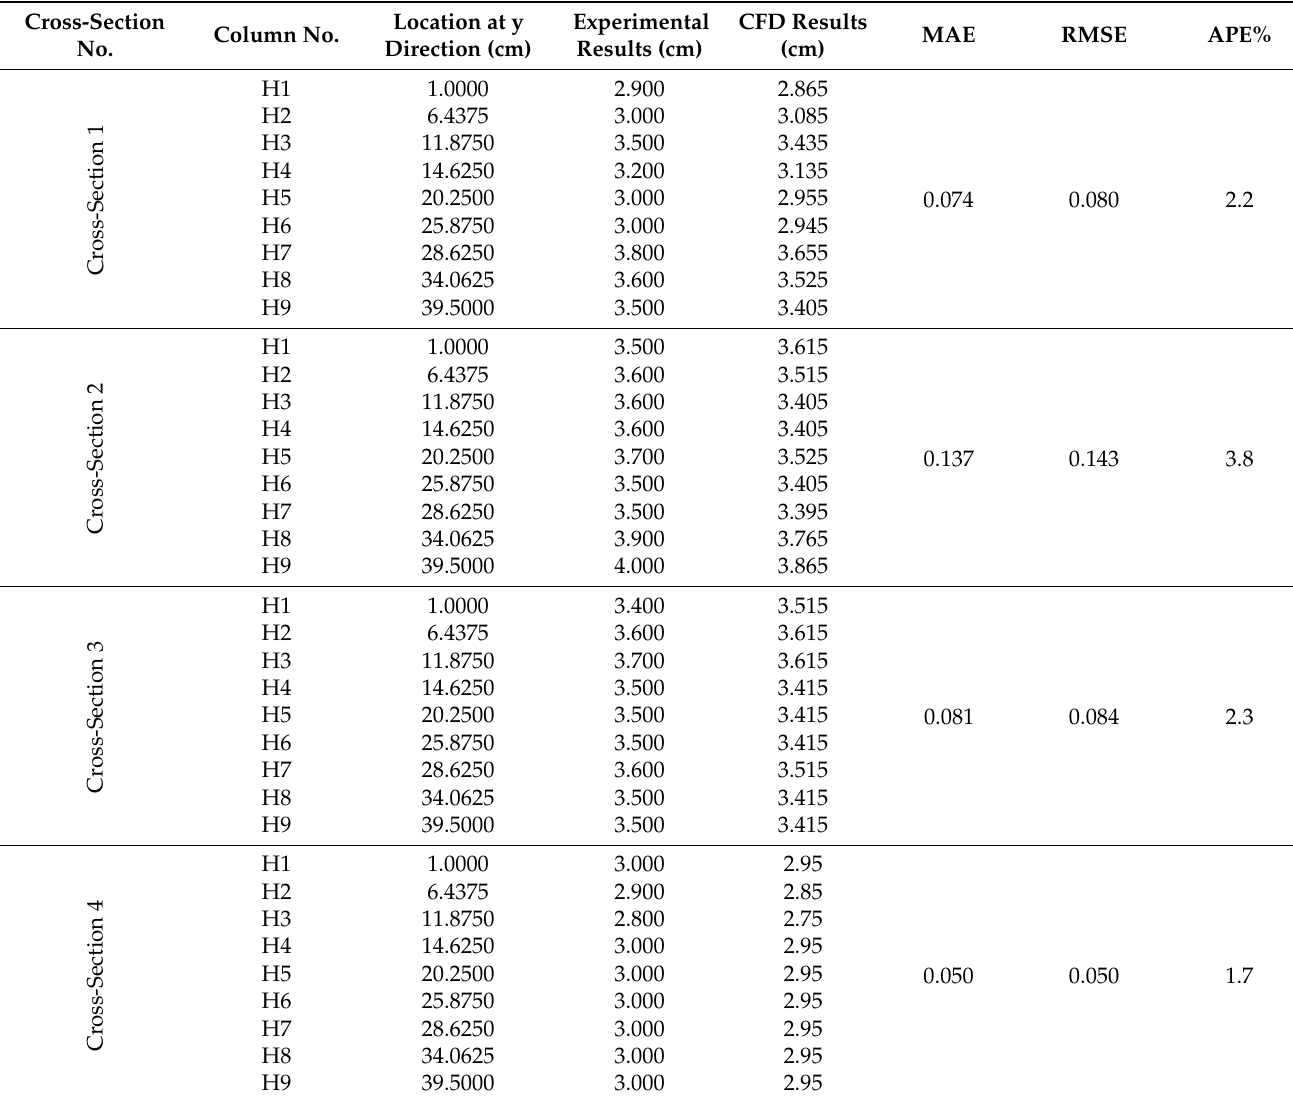
Table 5. Comparison of experiment and CFD water depth